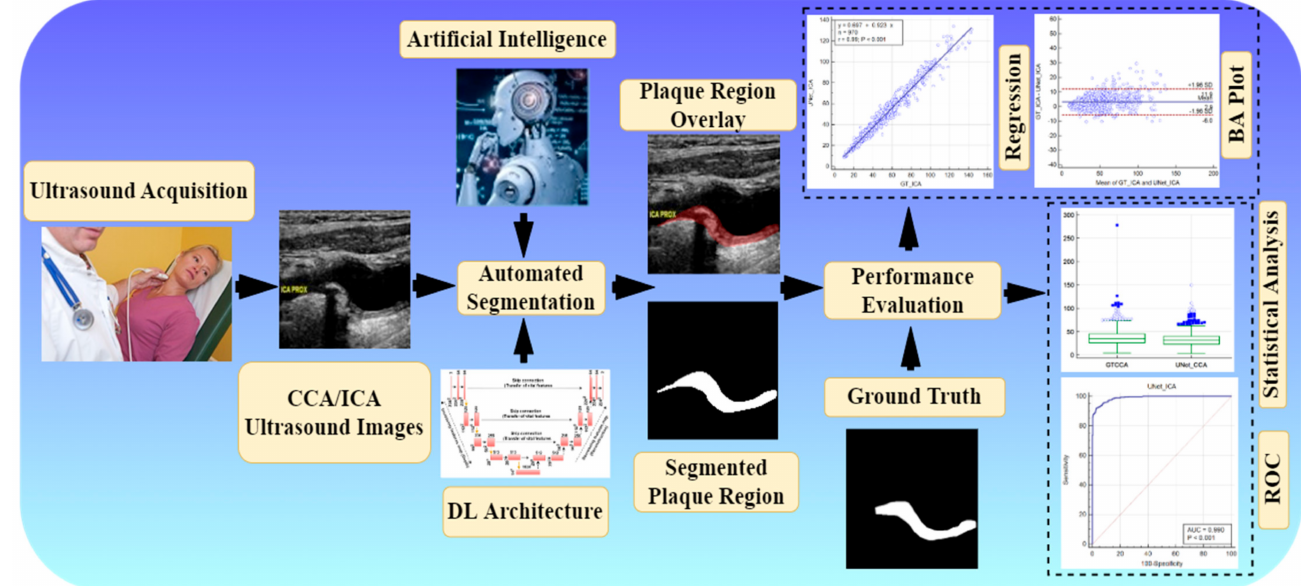
Figure 1. Global system (under the class of AtheroEdge™ 3.0) of carotid plaque